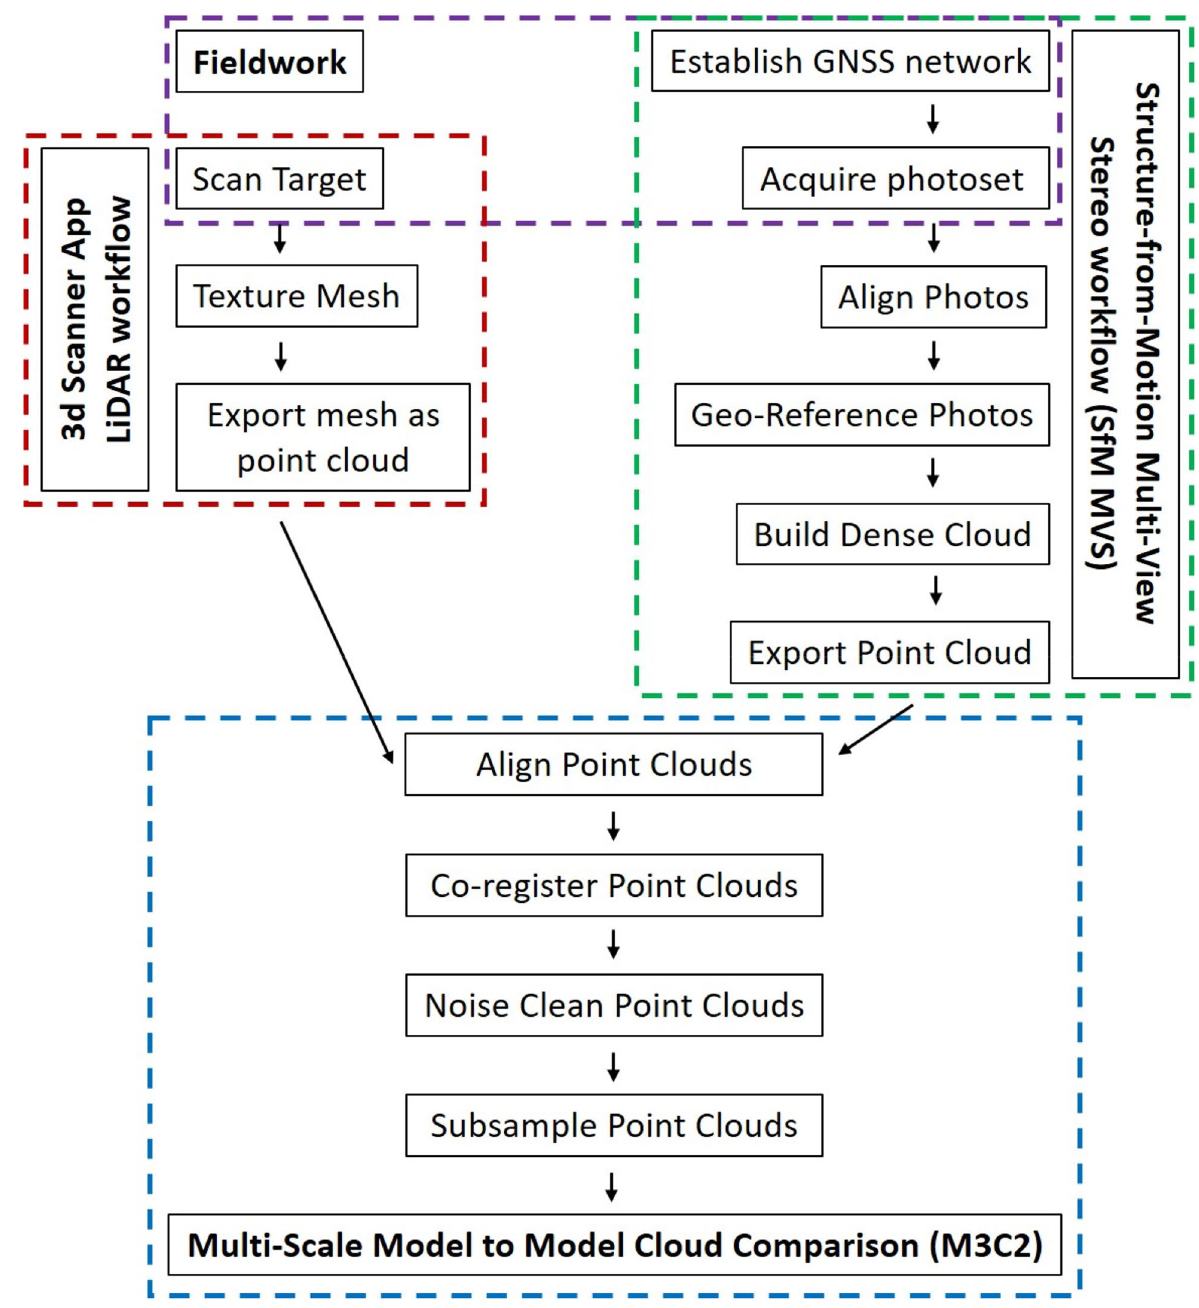
Figure 1. Workflow for the acquisition of the LiDAR point clouds with the ‘3d Scanner App’ (red box), the SfM MVS point clouds (green box) including fieldwork (purple box), and the Multi-Scale Model-to-Model Cloud Comparison (M3C2) in CloudCompare (blue